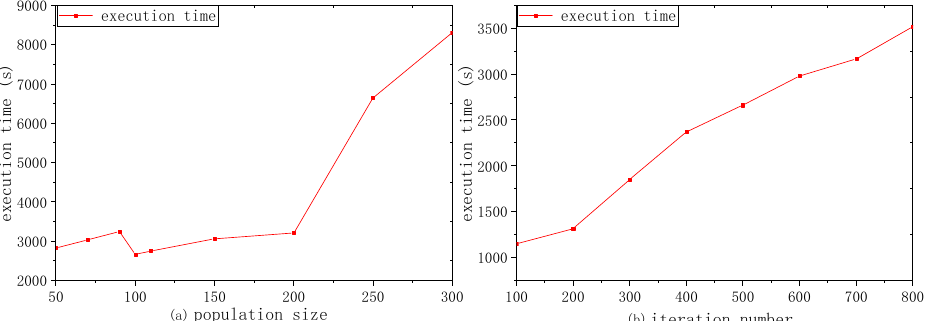
Figure 4. Execution time of different population size and iteration number.